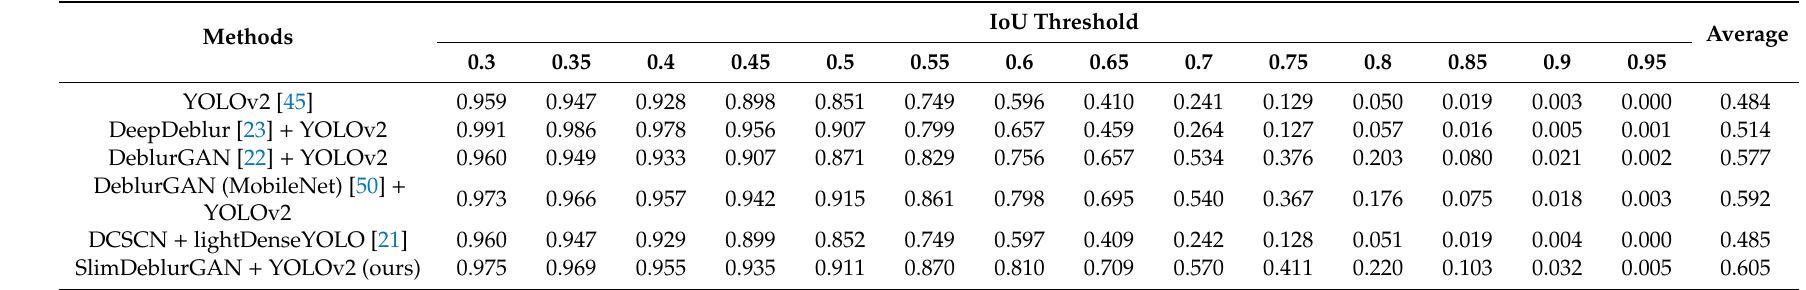
Table 13. Comparisons of recall on RMBD-DB1.